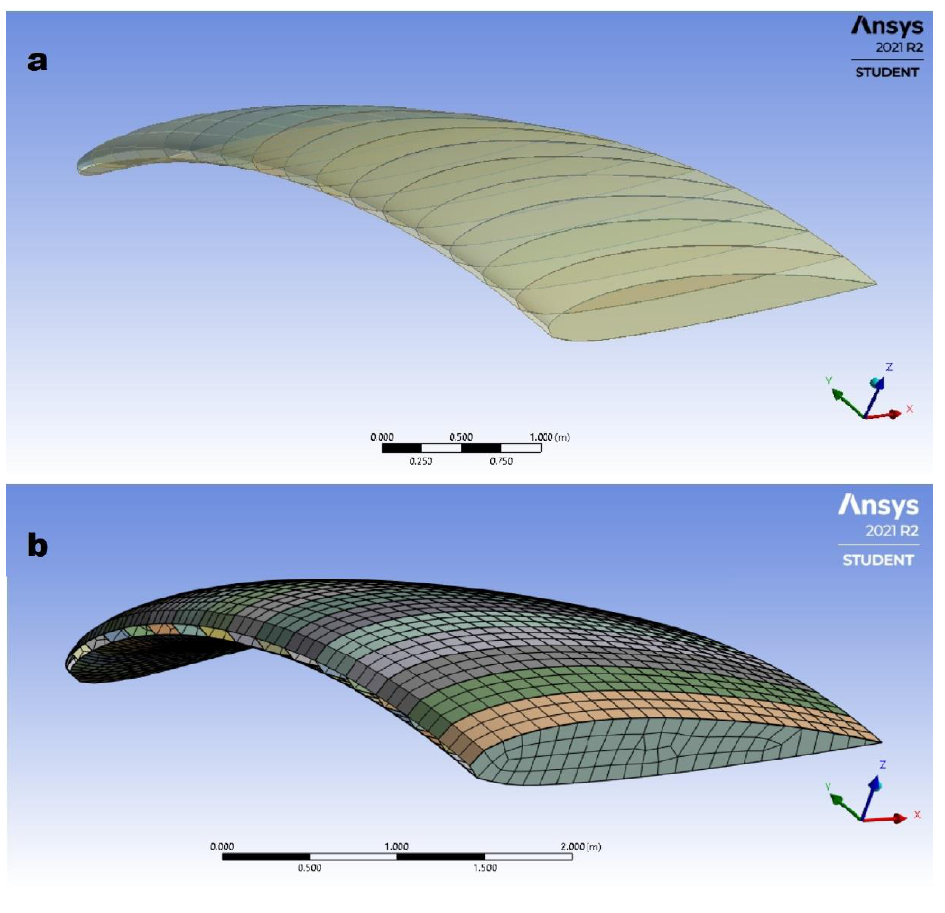
Figure 6. The model design: ( a ) geometry of a half of the considered paraglider; ( b ) FEM mesh.